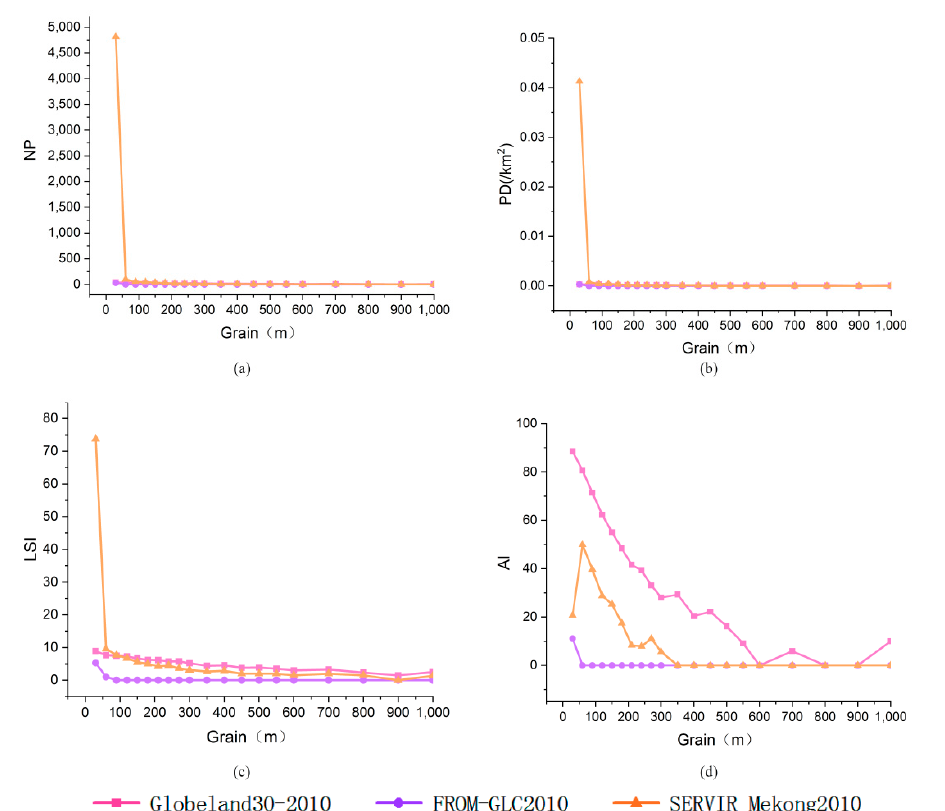
Figure 6. The wetland landscape pattern indices changing curves with scale increasing. ( a ) is the NP curve; ( b ) is the PD curve; ( c ) is the LSI curve; ( d ) is the AI curve.